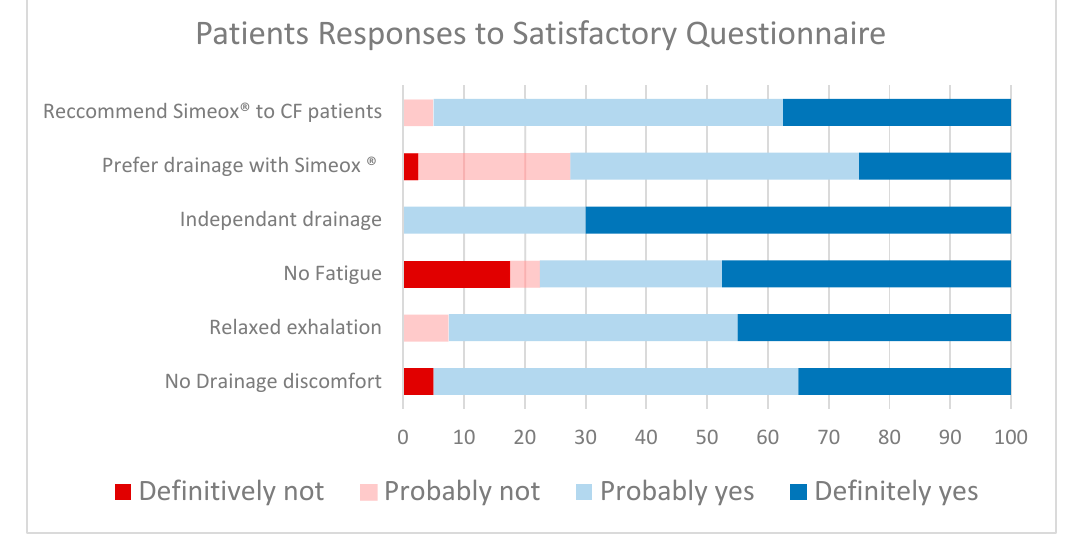
Figure 2. Patients Responses to Satisfactory Questionnaire.